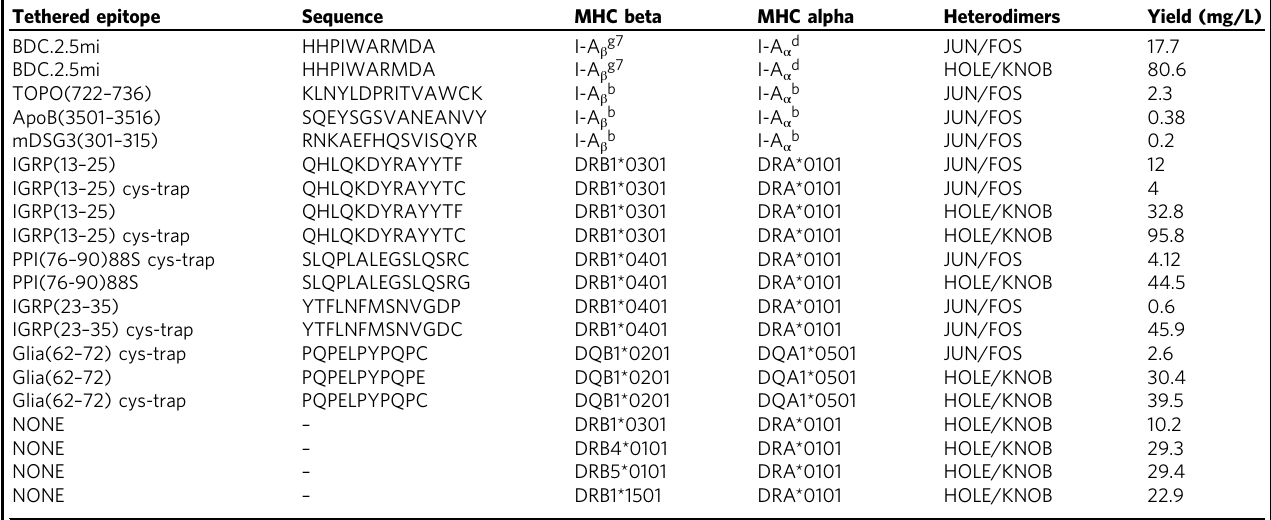
Table 1 Peptides, MHC molecules, heterodimerization domains and yields Tethered epitope